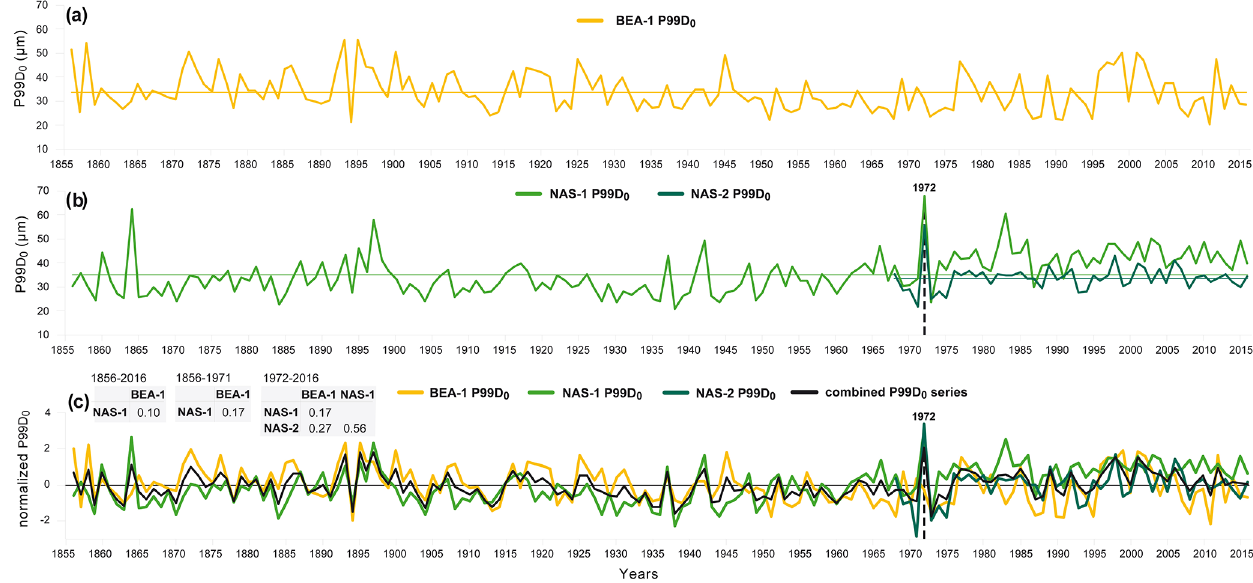
Figure 7. P99D 0 time series of cores (a) BEA-1, (b) NAS-1 (1856–2016) and NAS-2 (1968–2016). (c) Normalized P99D 0 series and the combined series (mean of the normalized data from the three sites). The 1972 marker layer is outlined by the black dashed line. Pearson correlation coefficients between the P99D 0 series for the 1856–2016, 1856–1971 and 1972–2016 periods are shown.